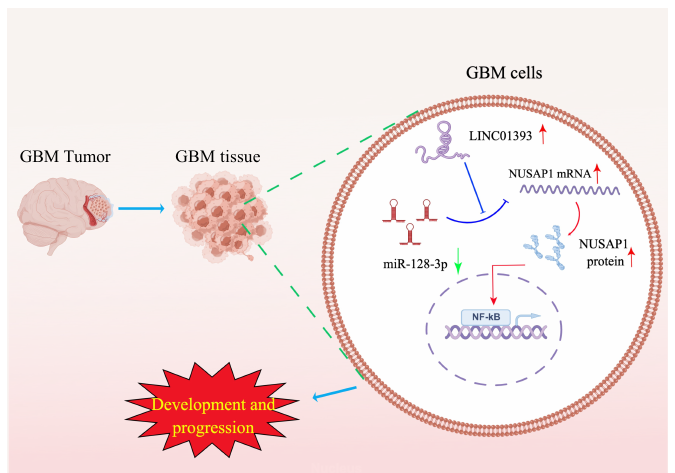
Figure 8. Functional mechanisms of LINC01393/miR-128-3p/NUSAP1 axis in GBM development Figure 8. Kinetics of phenolic compound release from freeze-dried microbeads containing grape po- and progression. (Red arrows show upregulation, green arrow shows downregulation, whereas mace extracts prepared with ( a ) sodium alginate (SA); ( b ) sodium alginate with chitosan (SA/CHIT); T-shaped bars indicate inhibitory ( c ) sodium alginate with gum arabic (SA + GA); and ( d ) sodium alginate with gelatin (SA + GEL) (symbols—experimental data, lines—approximate curves, according to the most suitable model).